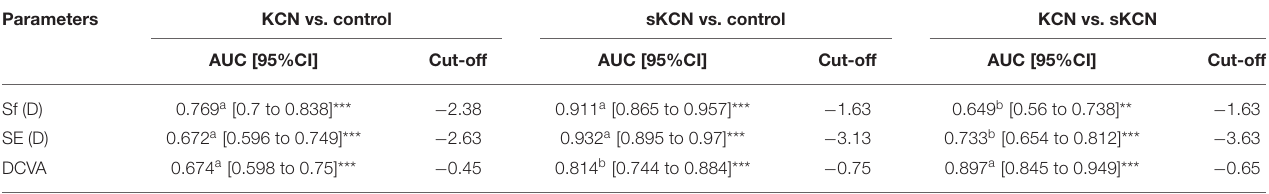
TABLE 7 | Refractive parameters and visual acuity AUCs and associated cut-off: KCN vs. control, sKCN vs. control, KCN vs. sKCN. Parameters